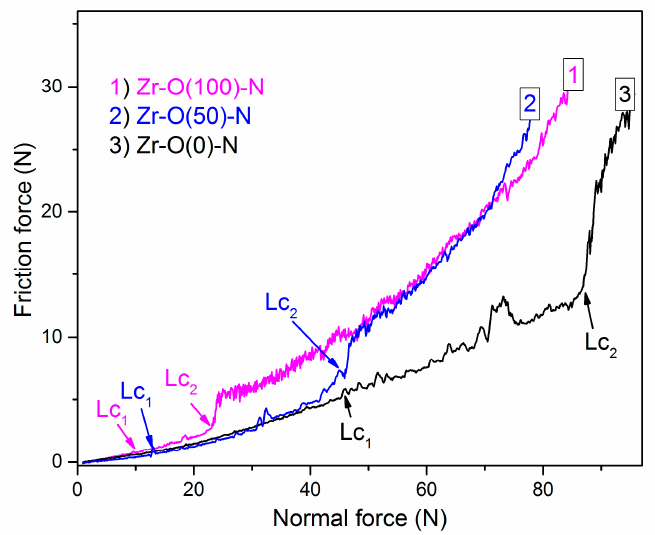
Figure 10. The friction force in scratch test on ZrON coatings with different O 2(x) plotted versus the applied load.